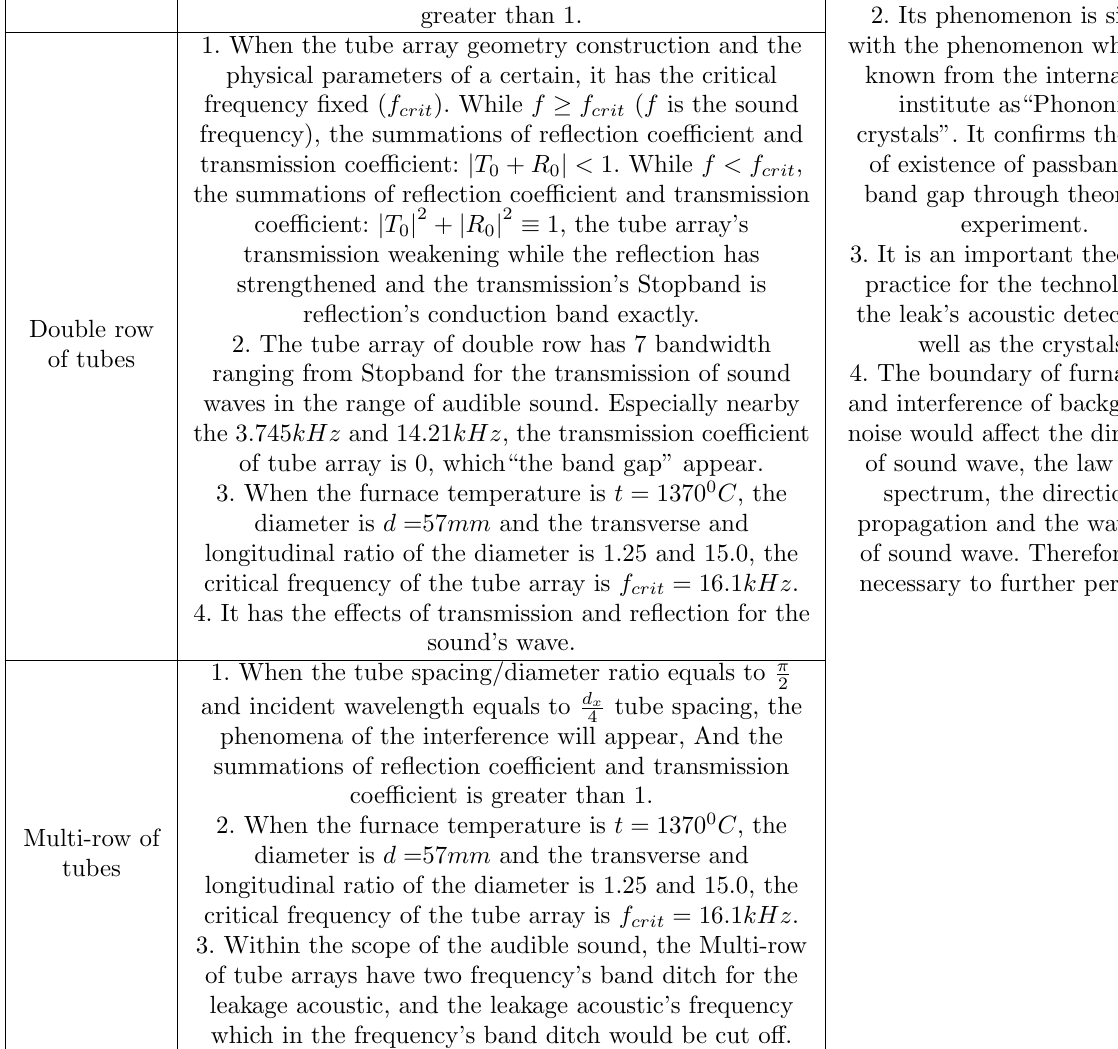
Table 2. The sound wave propagation characteristics of different kinds of heat exchanger’s pipe